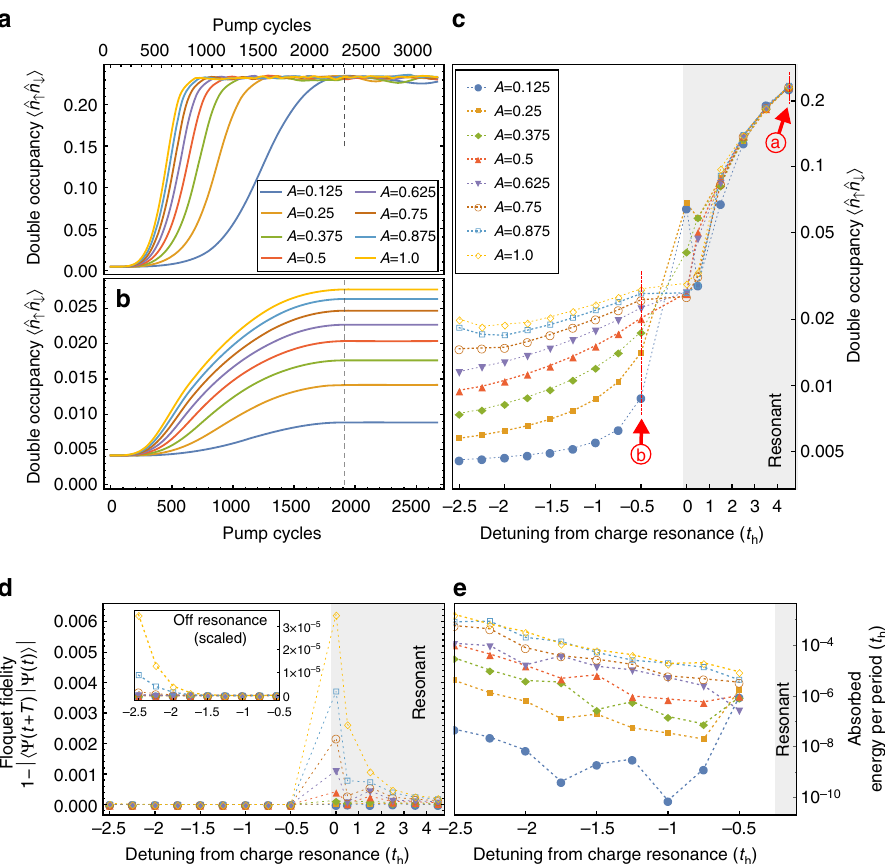
Fig. 5 Pre-thermalization and transient Floquet steady states. a , b depict the time evolution of the period-averaged local double occupancy of the 12-site driven Hubbard model as a function of cycles under the pump, on and off the charge resonance with the upper Hubbard band, respectively. Dashed lines indicate onset of the pump plateau. c Extracted transient expectation values of the double occupancy at the pump plateau, as a function of pump strength A and detuning from the upper Hubbard band. Red arrows indicate values of t h used for a , b . Lines are guides to the eye. On resonance ( gray region), the (cid:12) (cid:11) system heats rapidly, with ^ n " ^ n # thermalizating independent of the pump strength A and approaching its in fi nite-temperature expectation value 1/4. Below resonance ( white region ), the system transiently realizes the TRS-breaking chiral quantum magnet, with a tunable Hubbard interaction U (as well as correspondingly tunable magnetic J , χ , see Fig. 4) as a function of pump strength. d Floquet fi delity F ð T Þ ¼ Ψ t þ T ð Þ Ψ ð t Þjh ij j on the pump plateau — below charge resonance, (1 − F ) → 0, indicating the controlled preparation of a Floquet eigenstate. e Extracted stroboscopic heating rates per pump cycle and below resonance. Remarkably, heating is strongly suppressed close to the charge resonance, with the driven system requiring many thousands of pump cycles to fi nally absorb energy on the order of the Heisenberg exchange